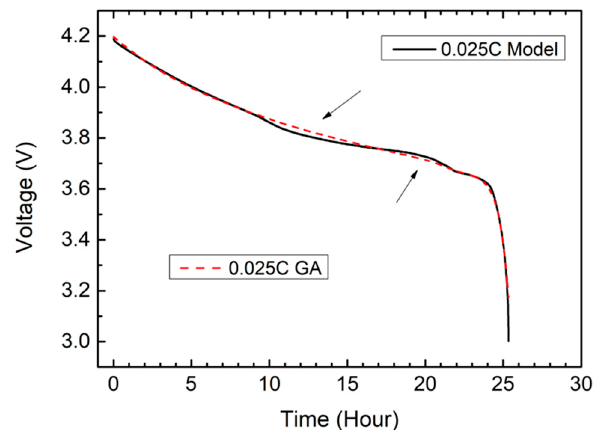
Figure 21. GA results 2 (P brand 18650).